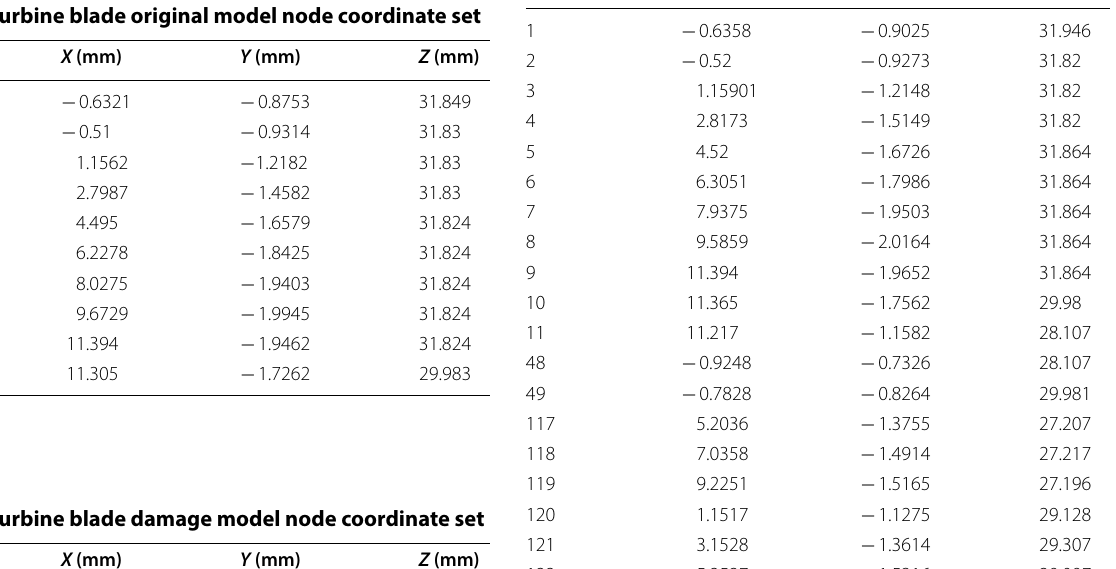
Figure 19 Two-dimensional display of turbine blade damage model Table 3 Turbine blade damage part node coordinate set